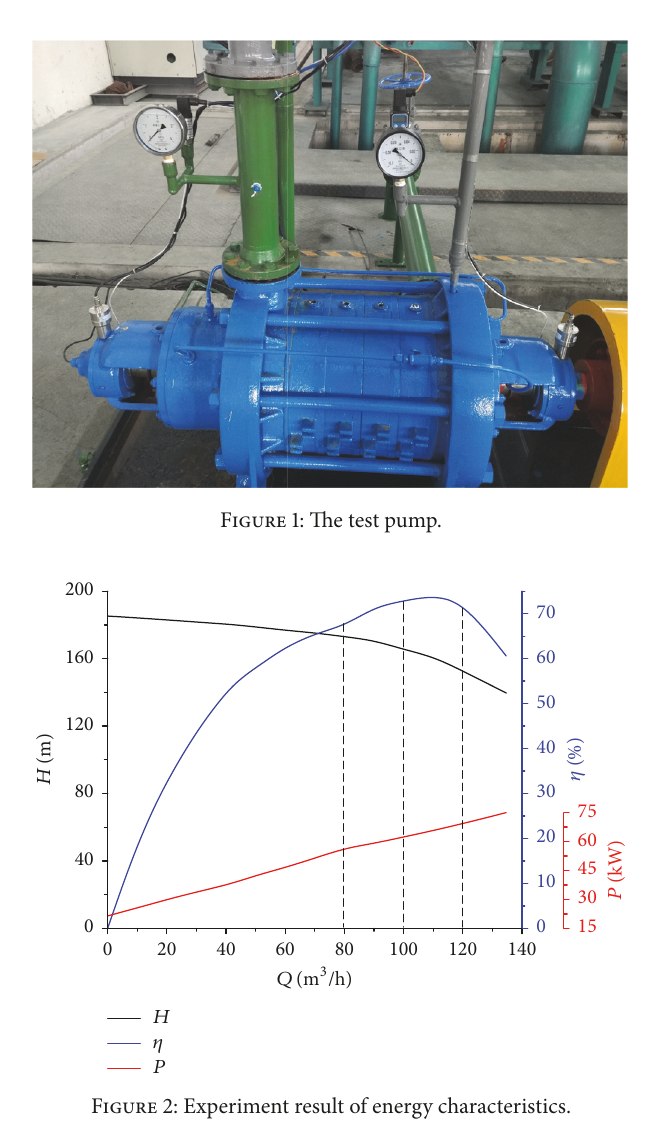
Figure 2: Experiment result of energy